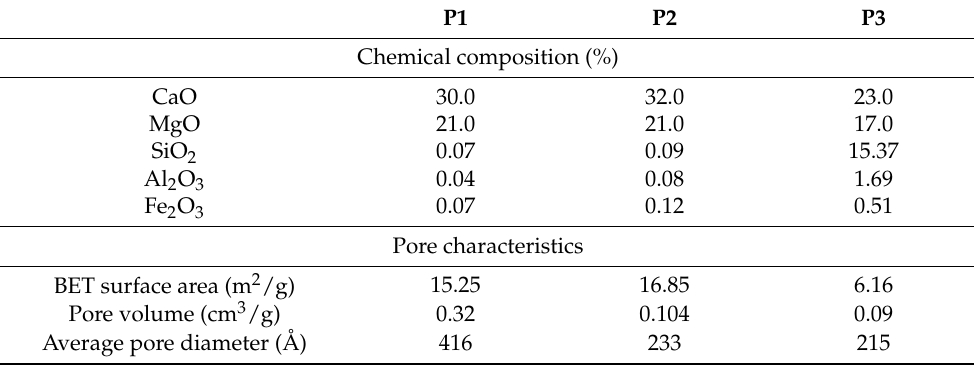
Table 1. Chemical composition and pore characterization of the catalysts (extracted from [29]).